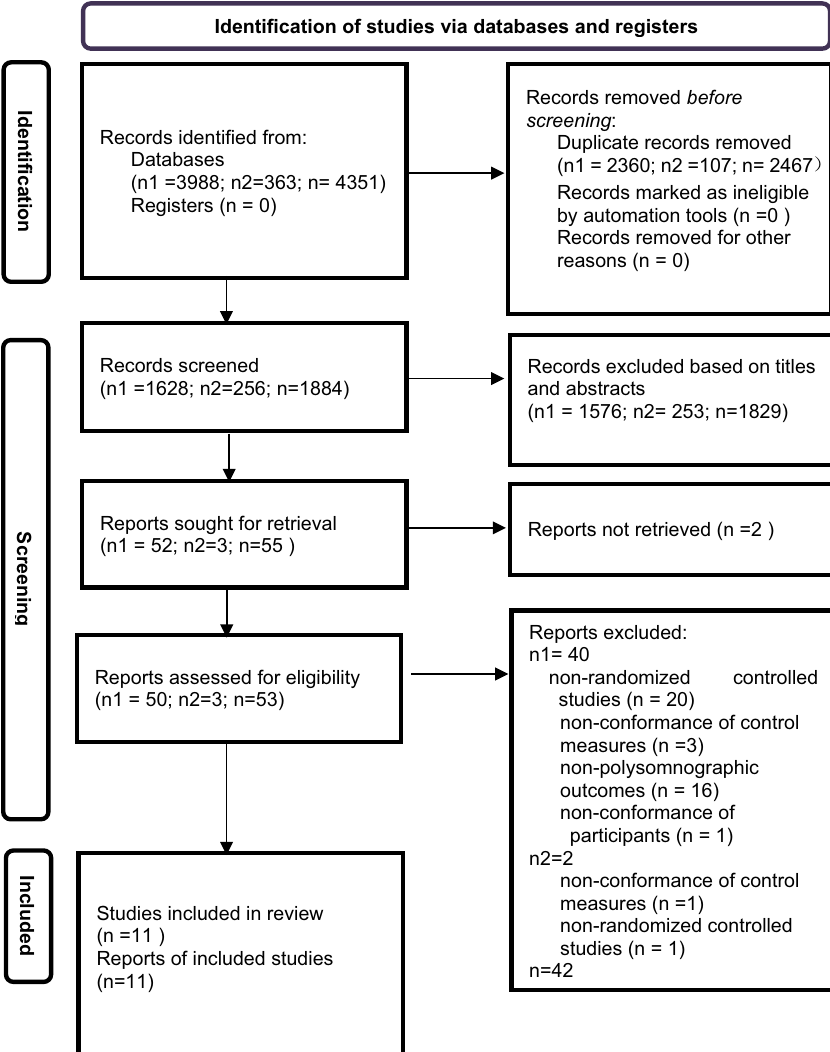
Figure 1. Flow diagram of the study selection process. n1 refers to The first literature search results, from the inception to July 2021. n2 refers to the second search results from July 2021 to June